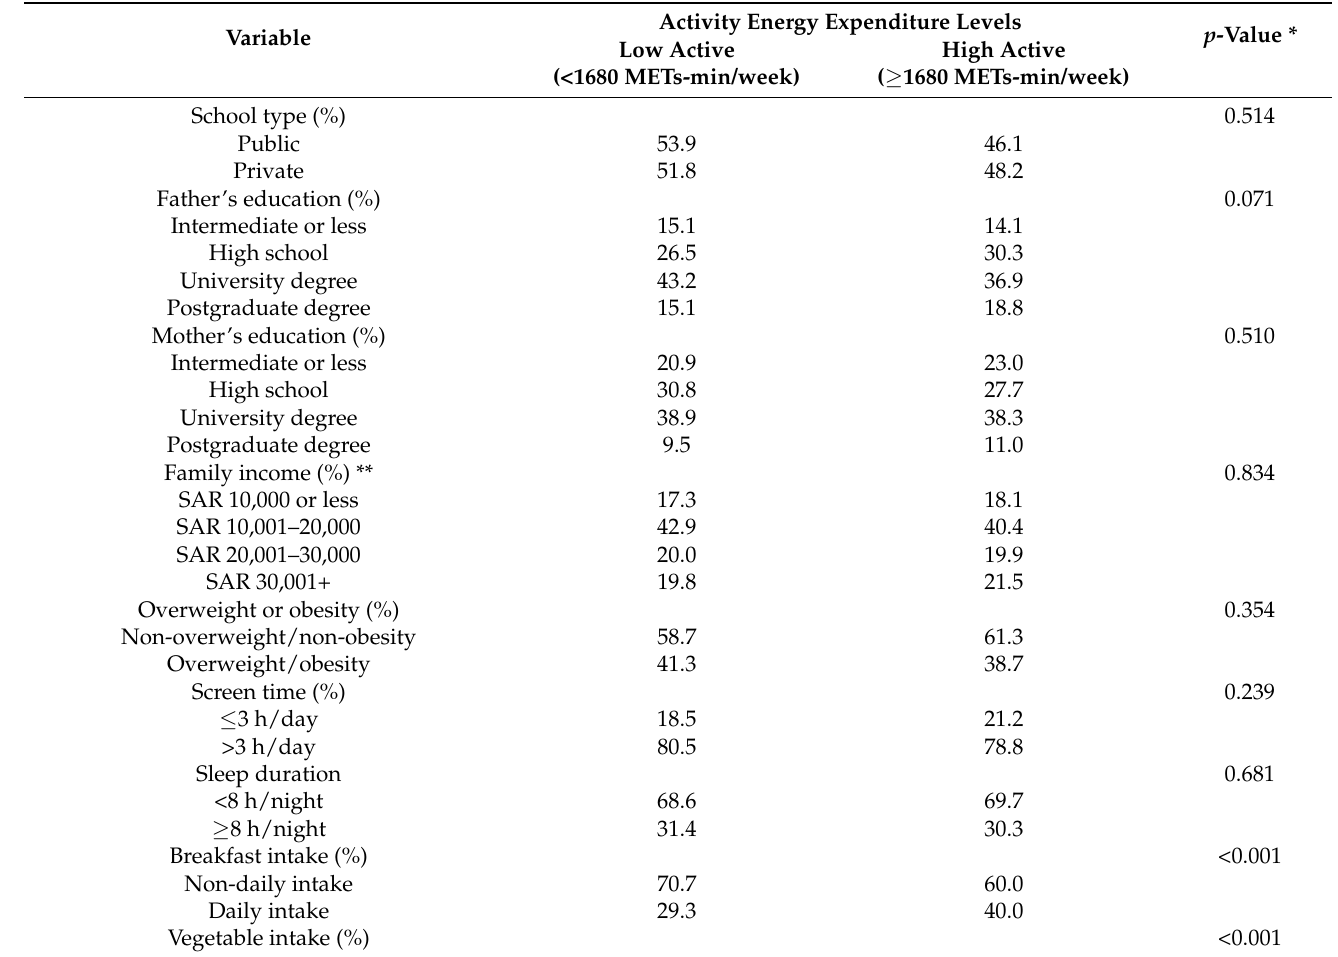
Table 4. The proportions (%) of socio-demographic and lifestyle factors relative to activity energy expenditure levels among the participating